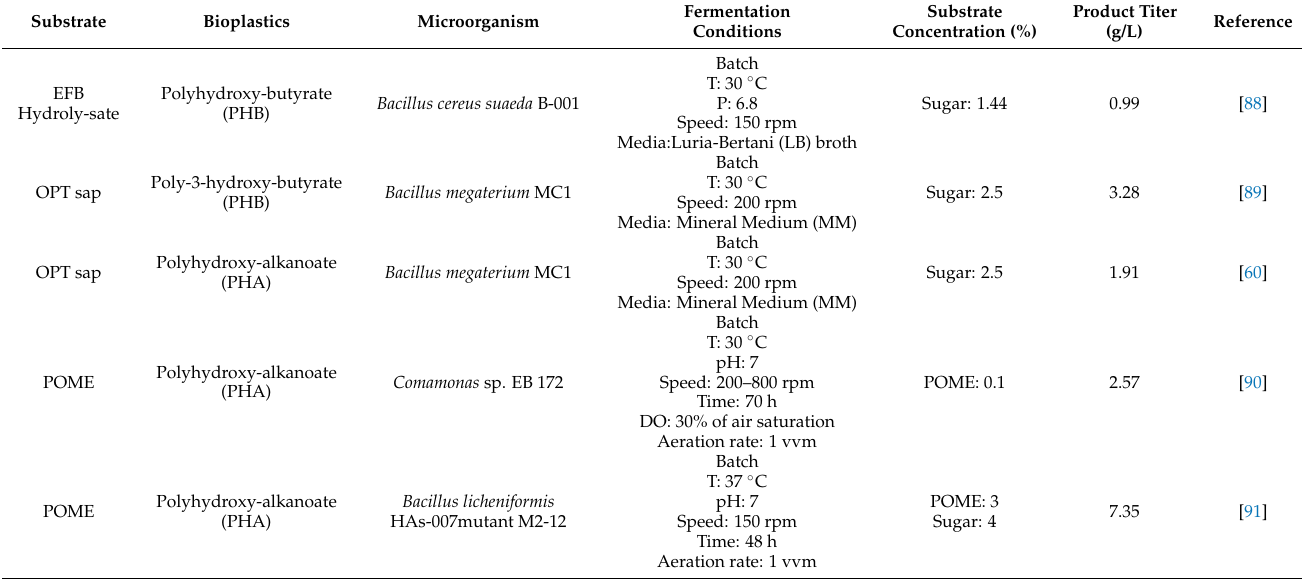
Table 3. Bioplastics production from oil palm biomass through the fermentation